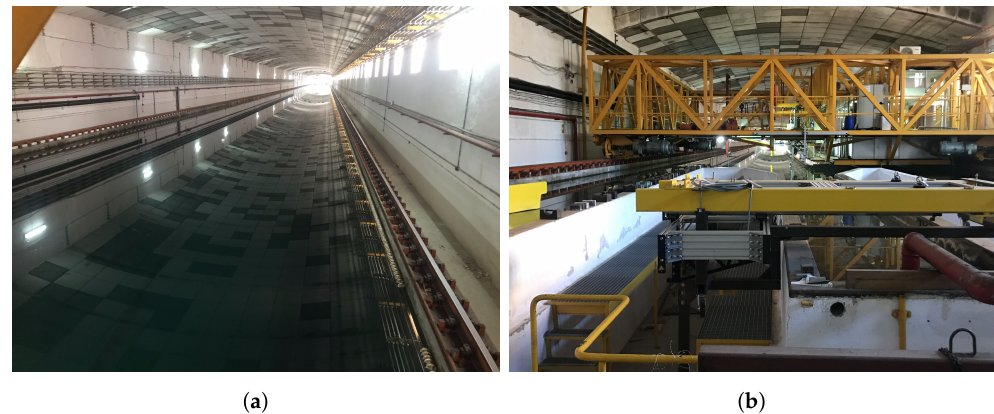
Figure 5. CEHIPAR facilities. ( a ) CEHIPAR towing tank. ( b ) CEHIPAR towing tank carriage. When the chain is submerged, it acquires a typical catenary shape, see Figure 6. The fairlead is connected to the moving and measurement devices and the bottom end of the chain is anchored to the floor. The anchor consisted of a heavy steel plate, 20 times the weight of the total length of the chain to avoid possible displacements during the tests. Special care has been taken to place the anchor at 25 m in the horizontal direction from the initial fairlead position to have the desired pretension for all the configurations.